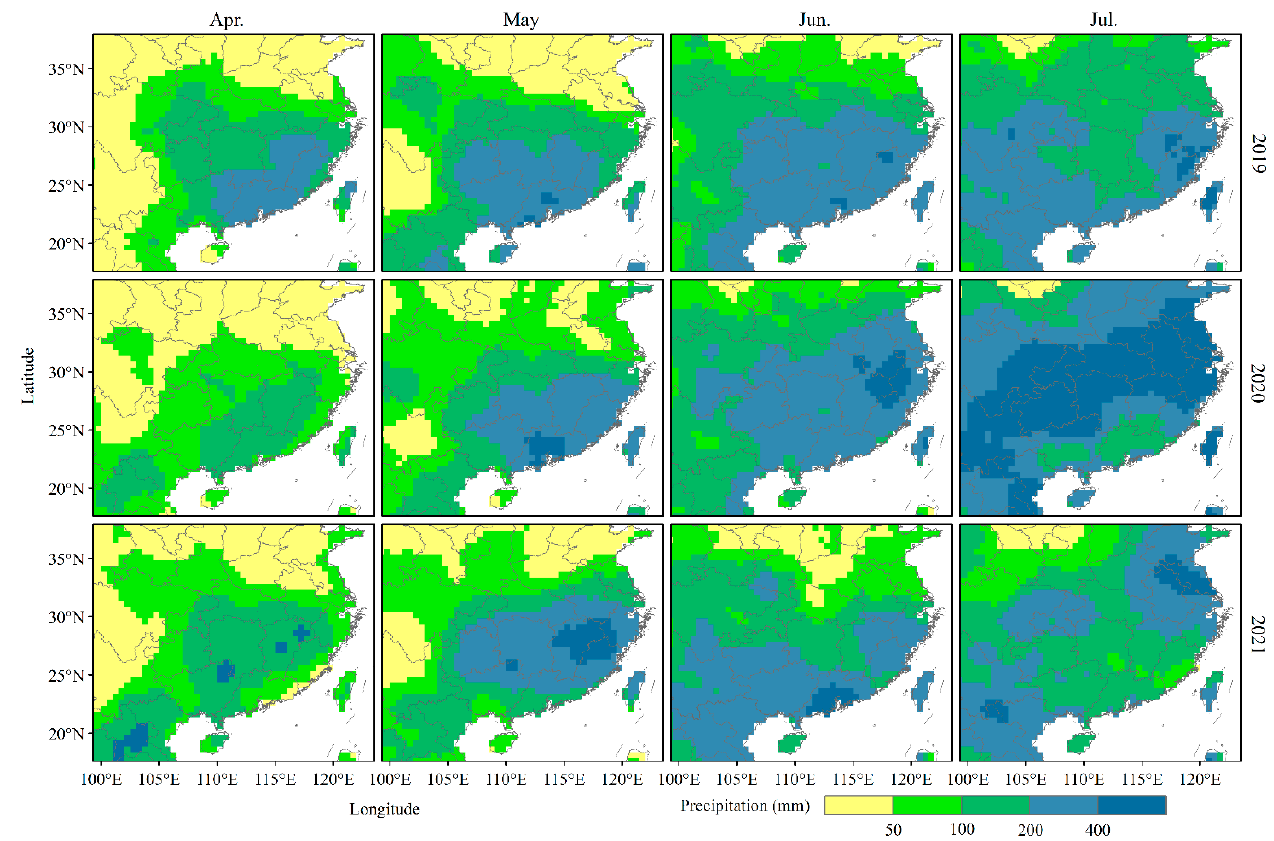
Figure 8. Monthly precipitation in Southern China from April to July of 2019 to 2021.